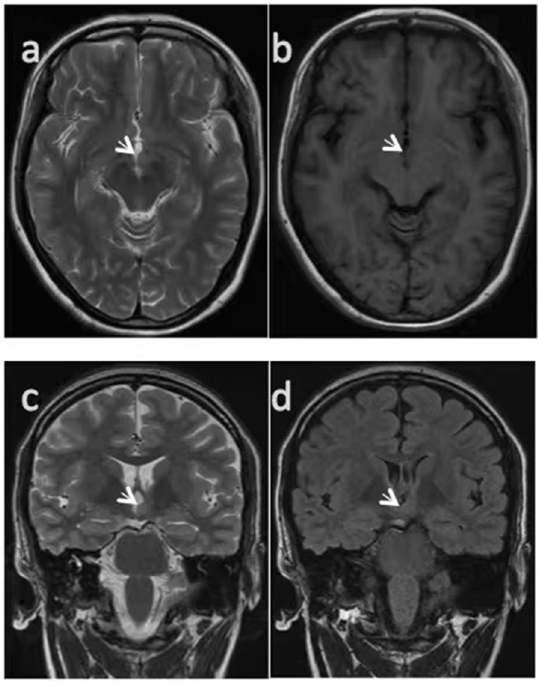
Fig. 1 Cranial magnetic resonance imaging (MRI). Axial T2WI ( a ), T1WI ( b ), coronal T2WI ( c ), and T2 FLAIR ( d ) all showed presence of HH in the left side, with equal signal shadows. The HH had a size of 9 mm * 5 mm, and protruded into the third